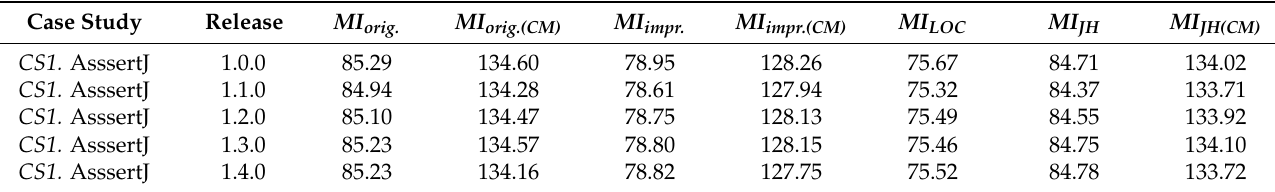
Table A2. Index variant values for CS1. AssertJ